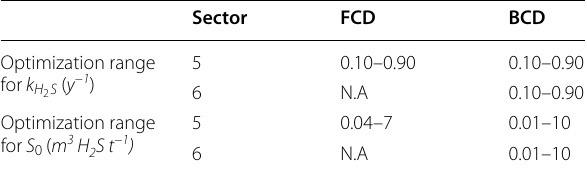
Table 5 Lower bounds and upper bounds of H optimization variables for Sectors 5 and 6